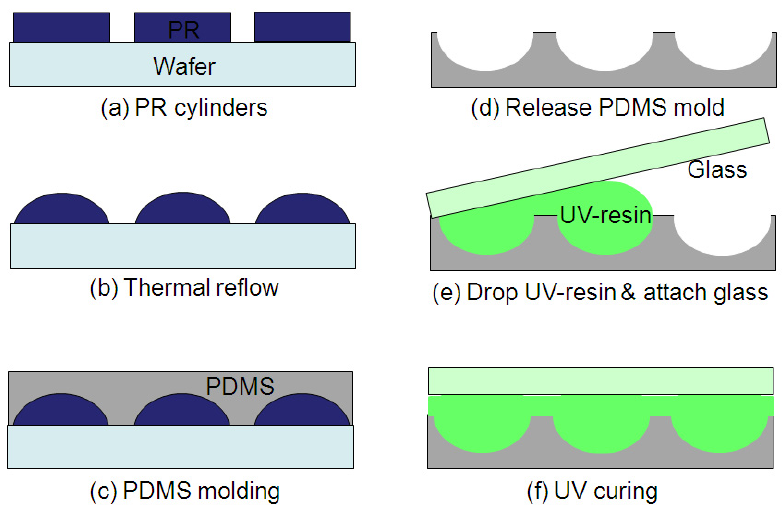
Figure 3. Fabrication steps of long-focal length MLA.